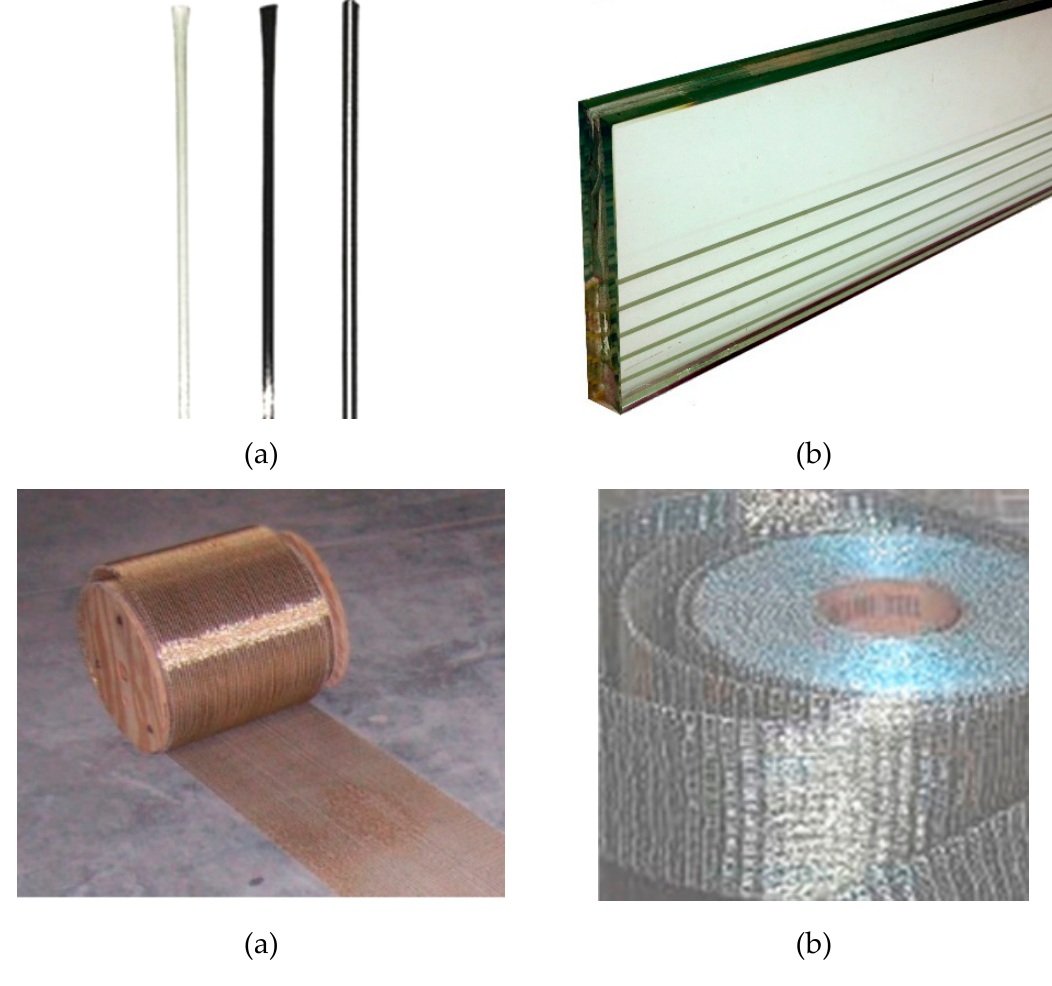
Figure 12. Examples of ( a ) textile rods acting as ( b ) embedded reinforcement in laminated glass beams (figures reproduced from [82] with permission from Elsevier, license n. 4581301243094, May 2019), as alternative to ( c )-(d) embedded ultra-high tensile strength steel or ( d ) stainless steel fibers (reproduced from [83] under the terms and conditions of CC BY license).